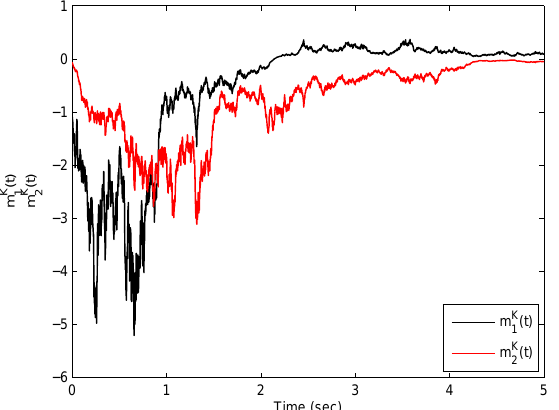
( t ) pertaining to the SMQVNN ( t ) , m K 2 1